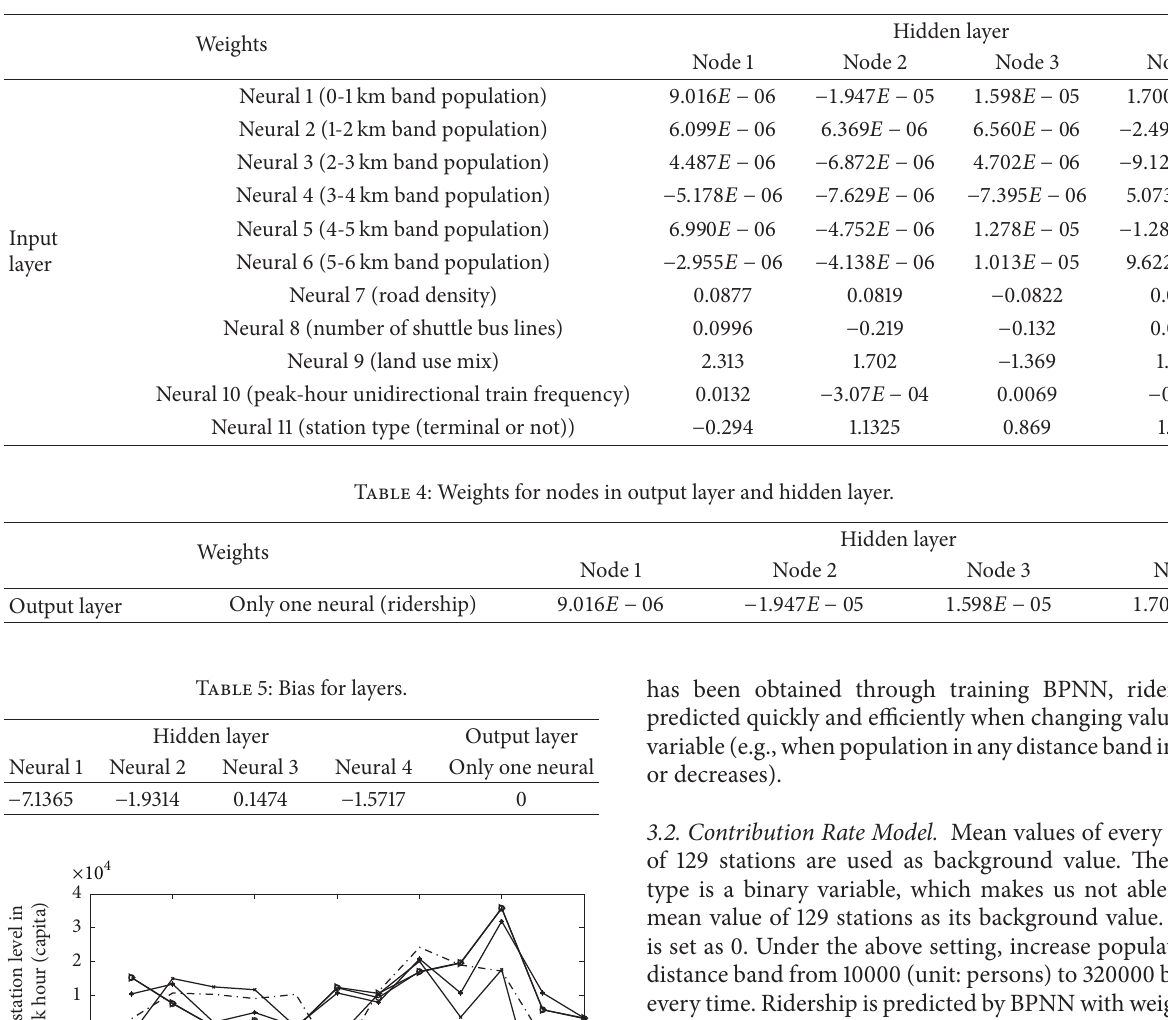
Table 3: Weights for nodes in input layer and hidden layer.